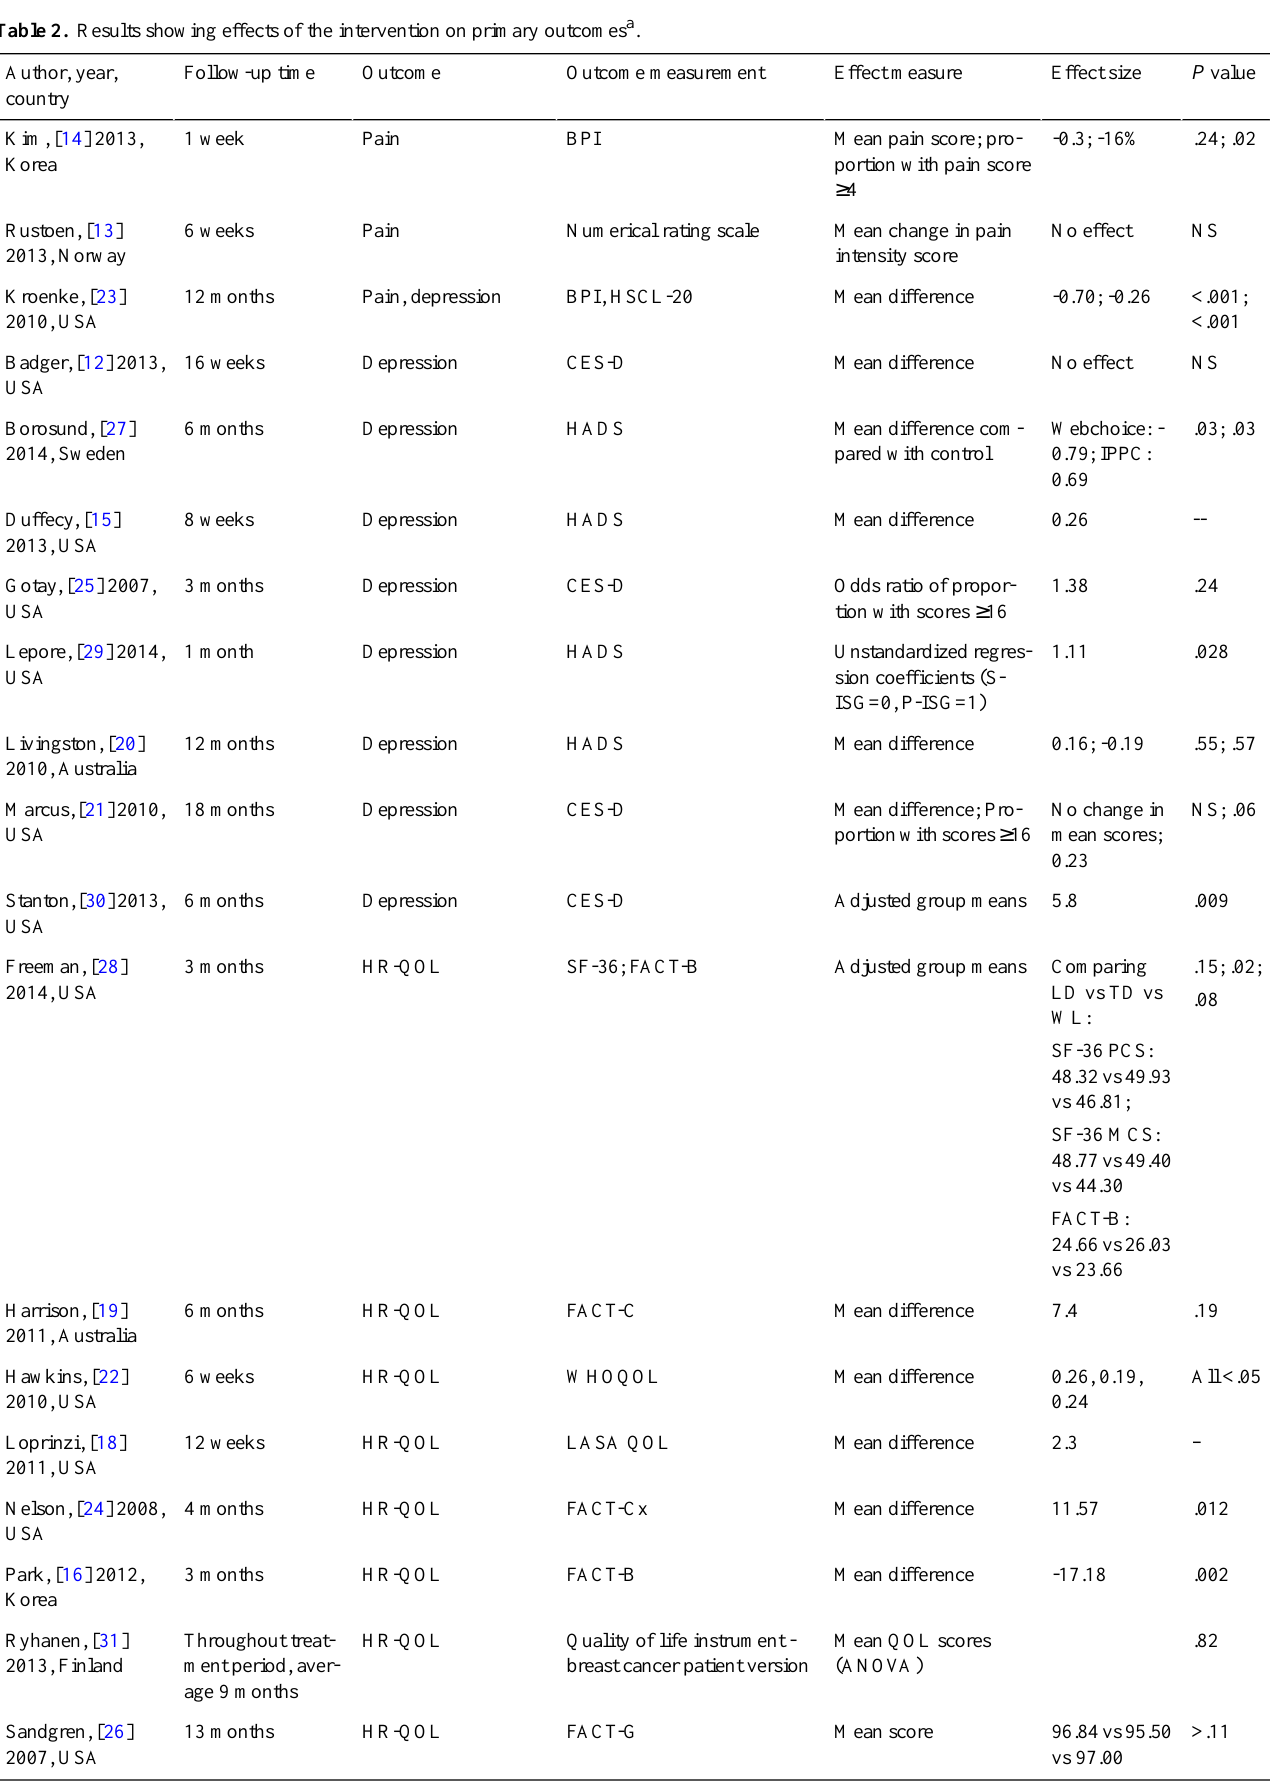
Table 2. Results showing effects of the intervention on primary outcomes a